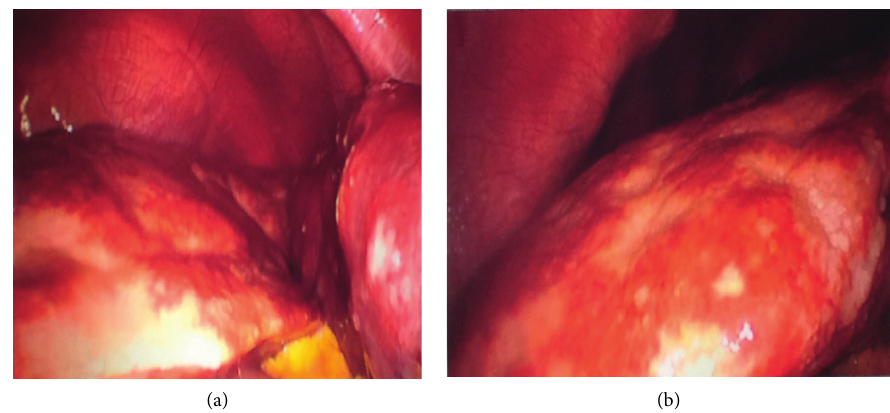
Figure 5: Exploratory laparoscopy showing infiltrative lesions.